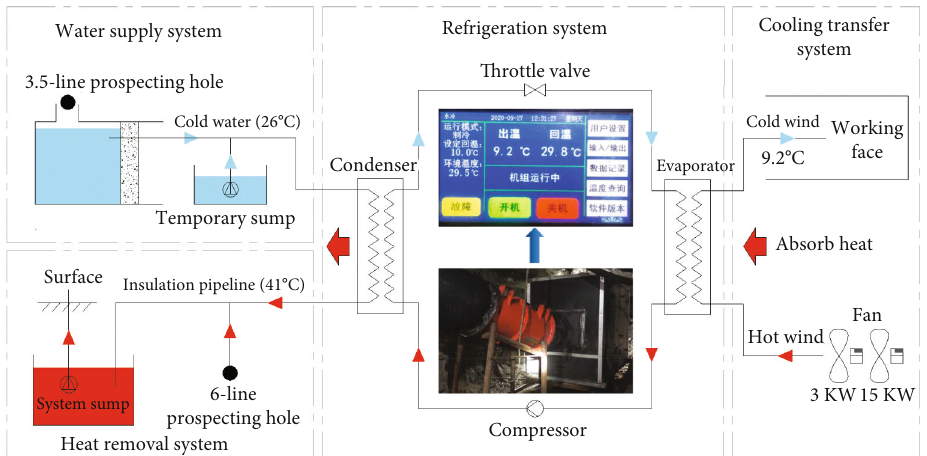
Figure 9: The optimized local cooling system.